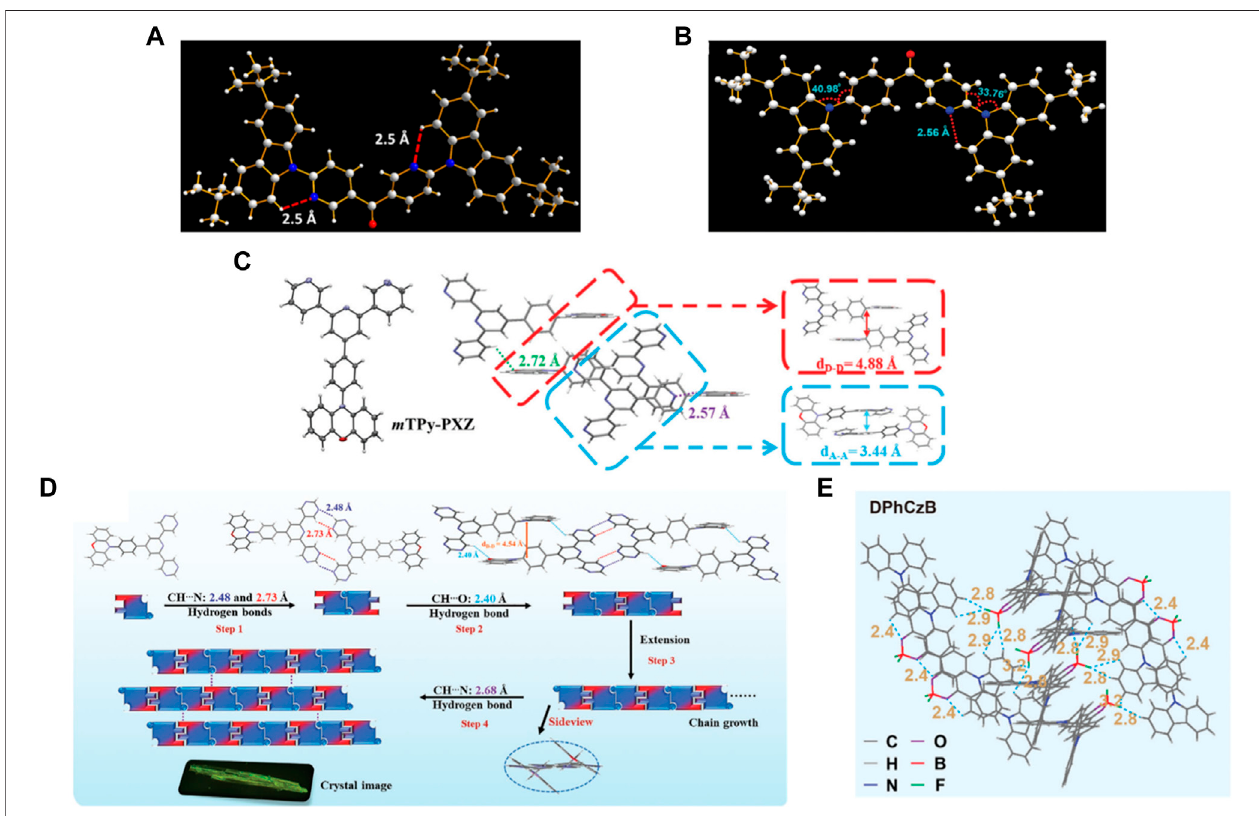
FIGURE2| TheH-bond interactions indifferentOLEDmaterials. (A) Crystalstructureof3DPyM- p DTC. (B) Themolecular structure andpacking diagramof3BPy- p DTC obtained from single-crystal X-ray diffraction analysis displaying the intramolecular H-bonding interaction and the donor-acceptor dihedral angles. (C) Thermal ellipsoid drawings at the 50% probability level and intermolecular geometries of m TPy-PXZ in the single crystals were determined by X-ray analysis. (D) Intermolecular packinggeometriesofDPmP-PXZinthesinglecrystaldeterminedbyX-rayanalysis. (E) Molecularpackingandinter-andintramolecularinteractionsintheDPhCzB